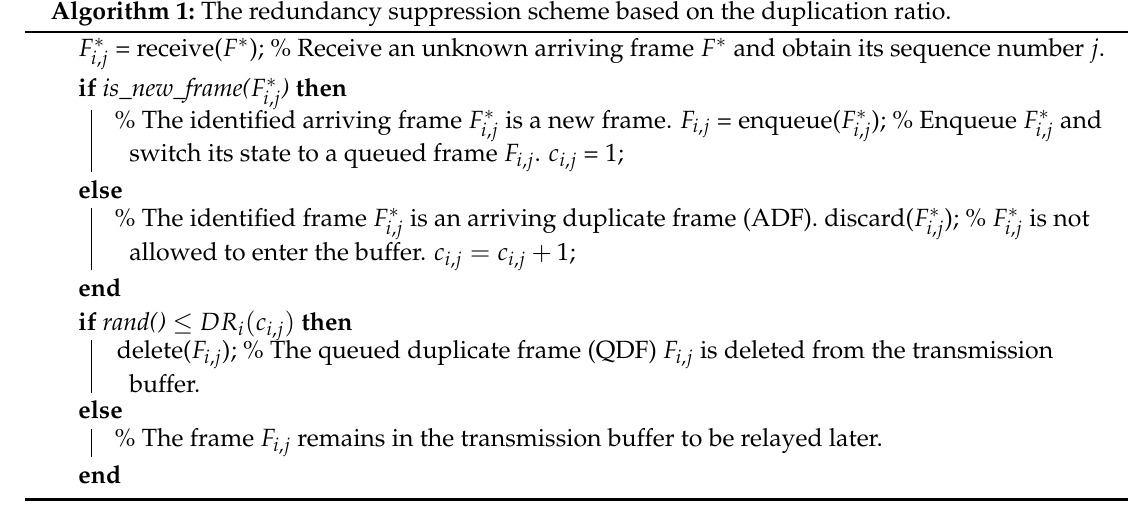
Algorithm 1: The redundancy suppression scheme based on the duplication